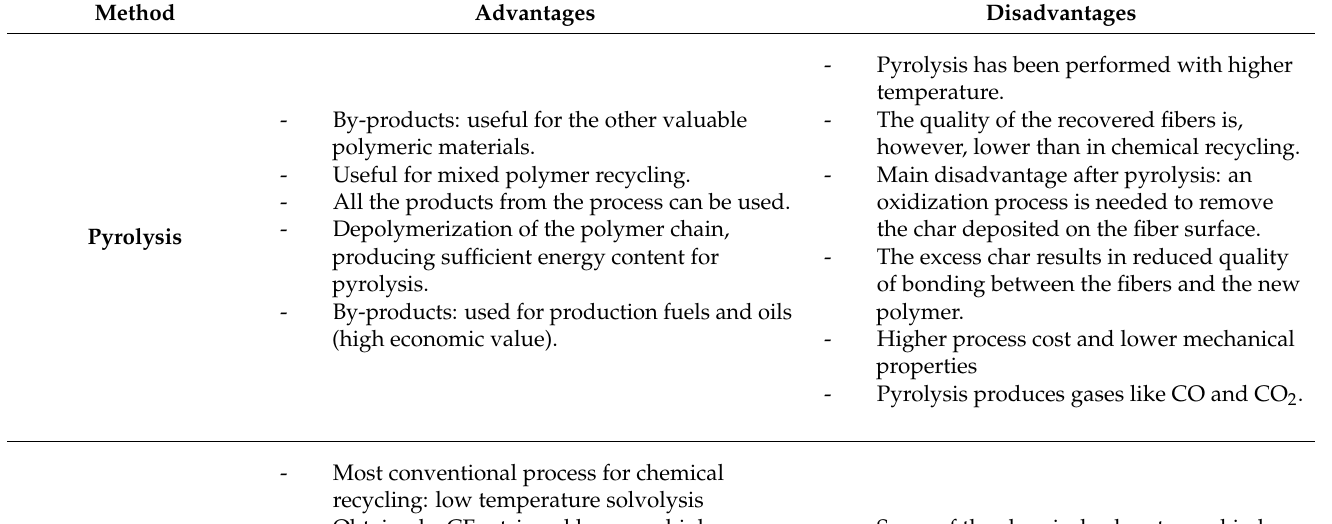
Table 2. Advantages and disadvantages of chemical and thermal recycling methods of Carbon Fibers (CFs) [102].